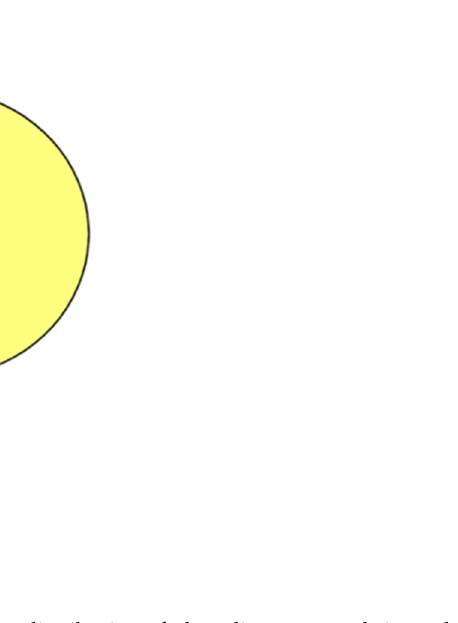
Figure 2. Venn diagram representation of the distribution of phenolic compounds in peel, pulp, and seed samples of the four varieties of avocados.